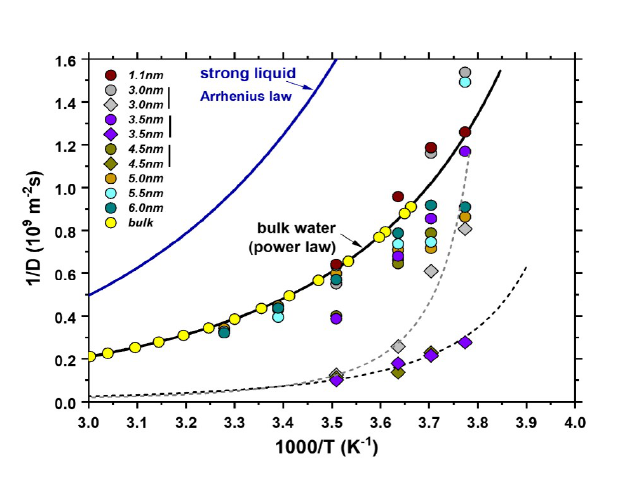
Figure 6. Experimental 1/D vs. 1000/T of the nanotube water in CNTs of various sizes, where D is the diffusivity and T the temperature in Kelvin. The blue lines (in both the main figure and the inset) are theoretical 1/D vs. 1000/T curves of an ideal “strong” liquid obeying the Arrhenius law. The yellow circles and the black line are the experimental values of bulk water and the relevant power-law fit. In CNT sizes of 3.0, 3.5, and 4.5nm, two water groups are resolved with different dynamics (slow and fast). The gray and the black dashed-lines are the power line fits of the data of the fast nanotube water group. The blue arrows are the relevant liquidus temperatures T l . The inset is magnification of the 1/D vs. 1000/T curves of the fast water component for CNT sizes 3.0, 3.5, and 4.5nm. Reprinted from Ref. [64], with the permission of AIP